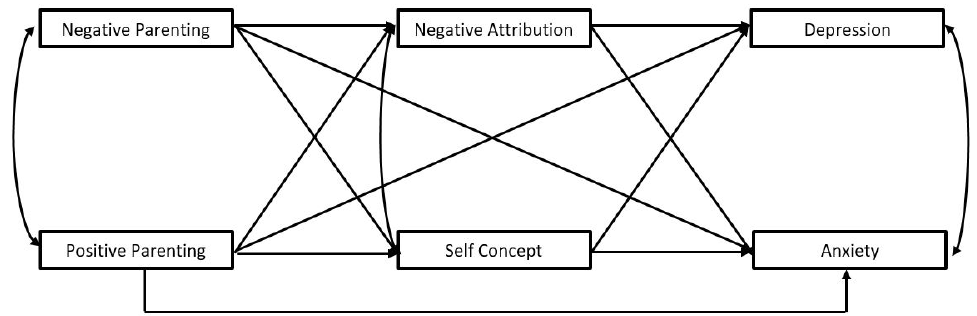
Figure 1. Proposed path